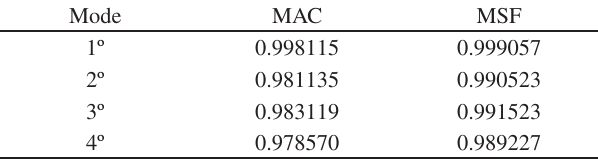
Table 4. MAC and MSF values between the numerical and experimental vectors for HLM graphite beam.